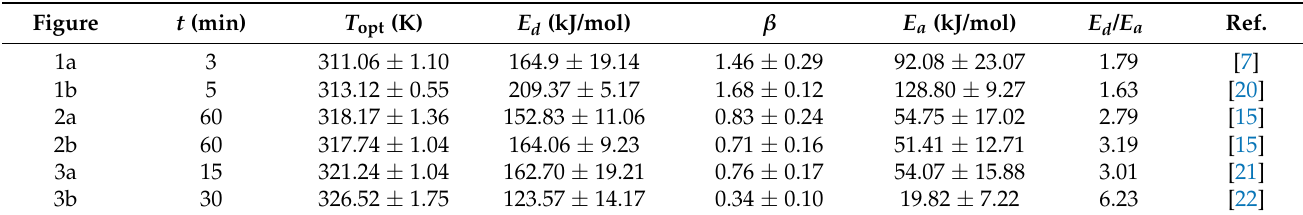
Table 1. The values of kinetic parameters estimated for α -amylase porcine